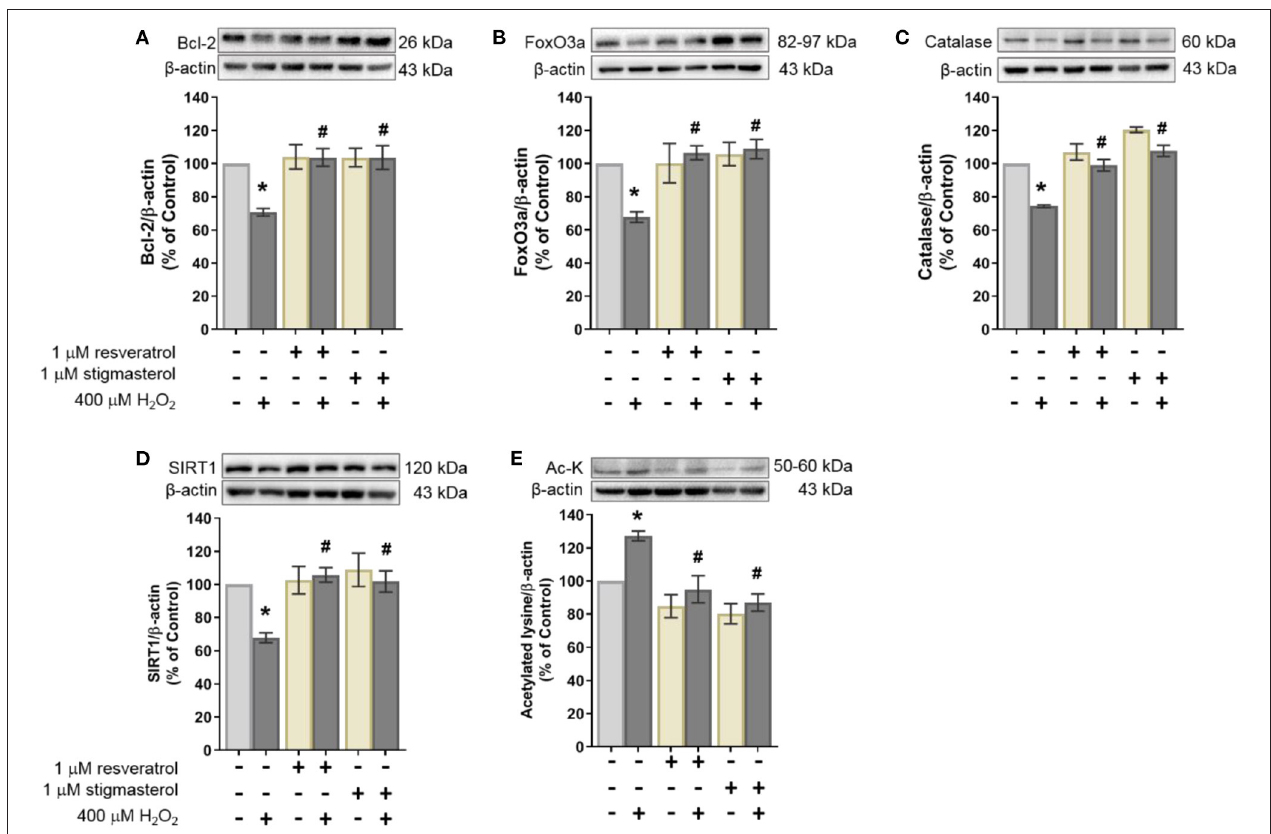
FIGURE 4 | Effects of resveratrol and stigmasterol on the expression level of (A) anti-apoptotic protein Bcl-2, (B) FoxO3a, (C) catalase, (D) SIRT1, and (E) acetylated lysine (Ac-K). Representative of protein bands determined by Western blot with β -actin as loading control are presented at the upper panel. Quantification of protein expression level is presented as ratios of each protein/ β -actin protein band intensity relative to the control group. Data are shown as the mean of three independent experiments ± S.E.M. (* p < 0.05 vs. control; # p < 0.05 vs. H 2 O 2 -treated